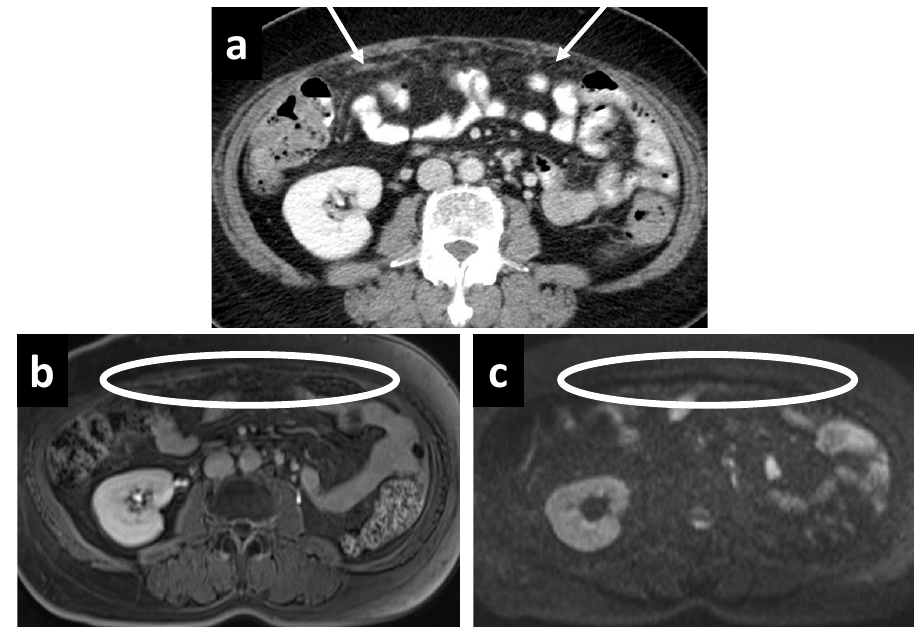
Figure 8. The superior spatial resolution of ( a ) CT is demonstrated here as irregular soft tissue stranding within the greater omentum, which is not appreciated on ( b ) delayed and ( c ) DW-MRI performed on the same day.